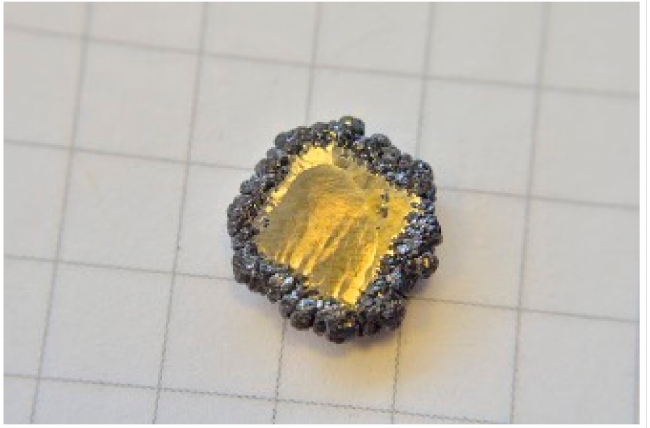
Figure 6. An M-CVD diamond with a polycrystalline